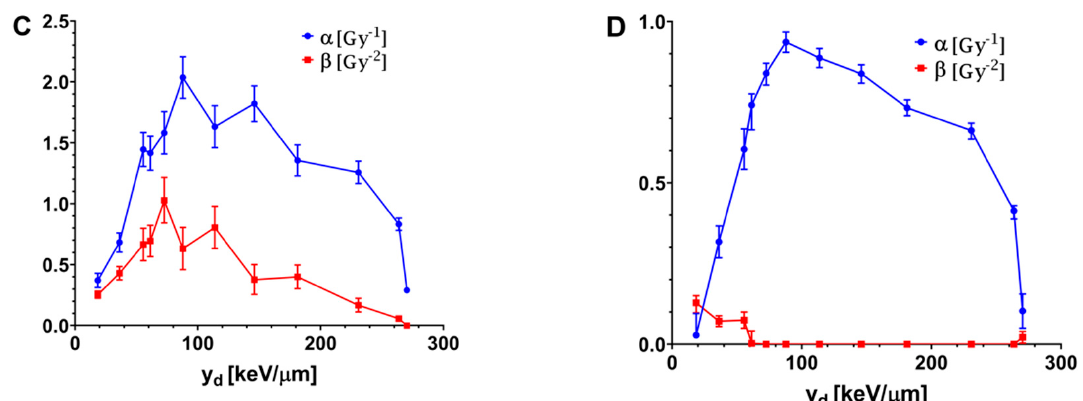
Figure 3. Clonogenic assay results from carbon ion irradiations performed at Heidelberg Ion Therapy Center in the ( A ) H460 and ( B ) H1437 cell lines. A high-throughput irradiation apparatus was designed to simultaneously expose cells to 12 locations along a 153.66 MeV/u carbon ion beam. Similar to the helium ion results (Figure 2), an inflection point was found for carbon ion irradiations at 87.9 keV/ μ m. The rate of surviving fraction reduction for cells exposed to carbon ions below this LET d was found to continually increase. The rate of surviving fraction reduction began to decrease for exposure to carbon ion y d s above 87.9 keV/ μ m. Error bars are SEM. ( C ) α (blue) and β (red) values calculated by fitting the H460 clonogenic survival data for cells exposed to carbon ions to the linear-quadratic model. ( D ) Linear-quadratic model α (blue) and β (red) values for the H1437 cells exposed to carbon ions.